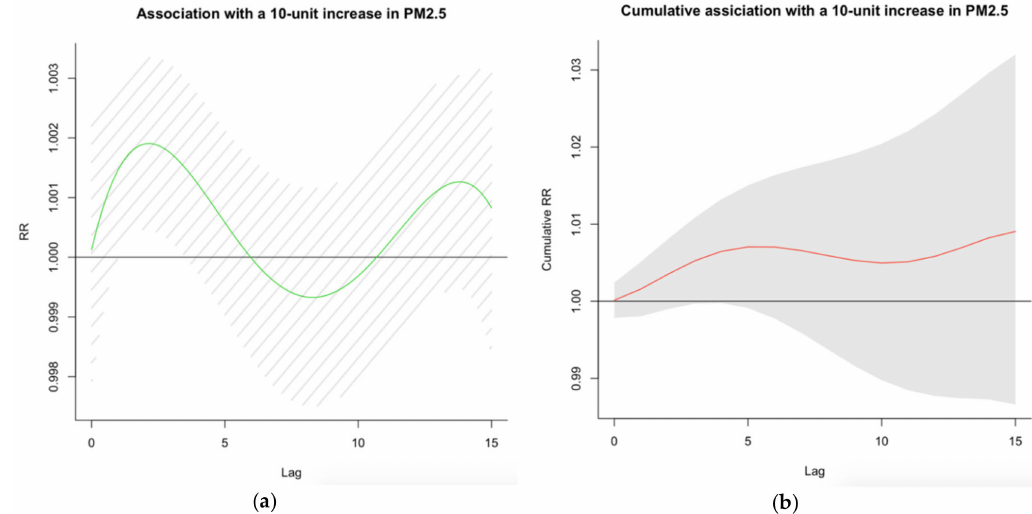
Figure 2. ( a ) Fifteen-day lag patterns and ( b ) cumulative lag patterns of risk for PM 2.5 -associated CVD mortality. The x-axes are lag days, ranging from lag day 0 to lag day 15; the y-axes are risk ratio (RR) or cumulative RR with 95% confidence interval for daily CVD mortality per 10 µ g / m 3 increase in PM 2.5 concentration. Table 2. Risk ratio (95% confidence interval) of lag e ff ects for single days and cumulative lag e ff ects per 10 µ g / m 3 increase in PM 2.5 concentration. Lag Day Single Day E ff ect Cumulative E ff